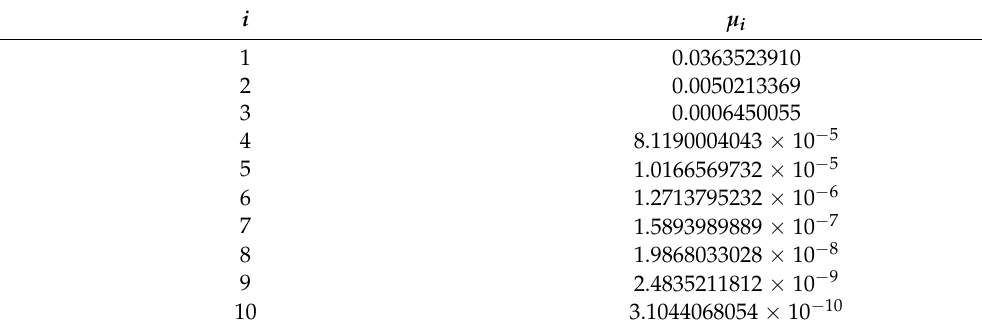
Table 4. Value of µ i constants for the first 10